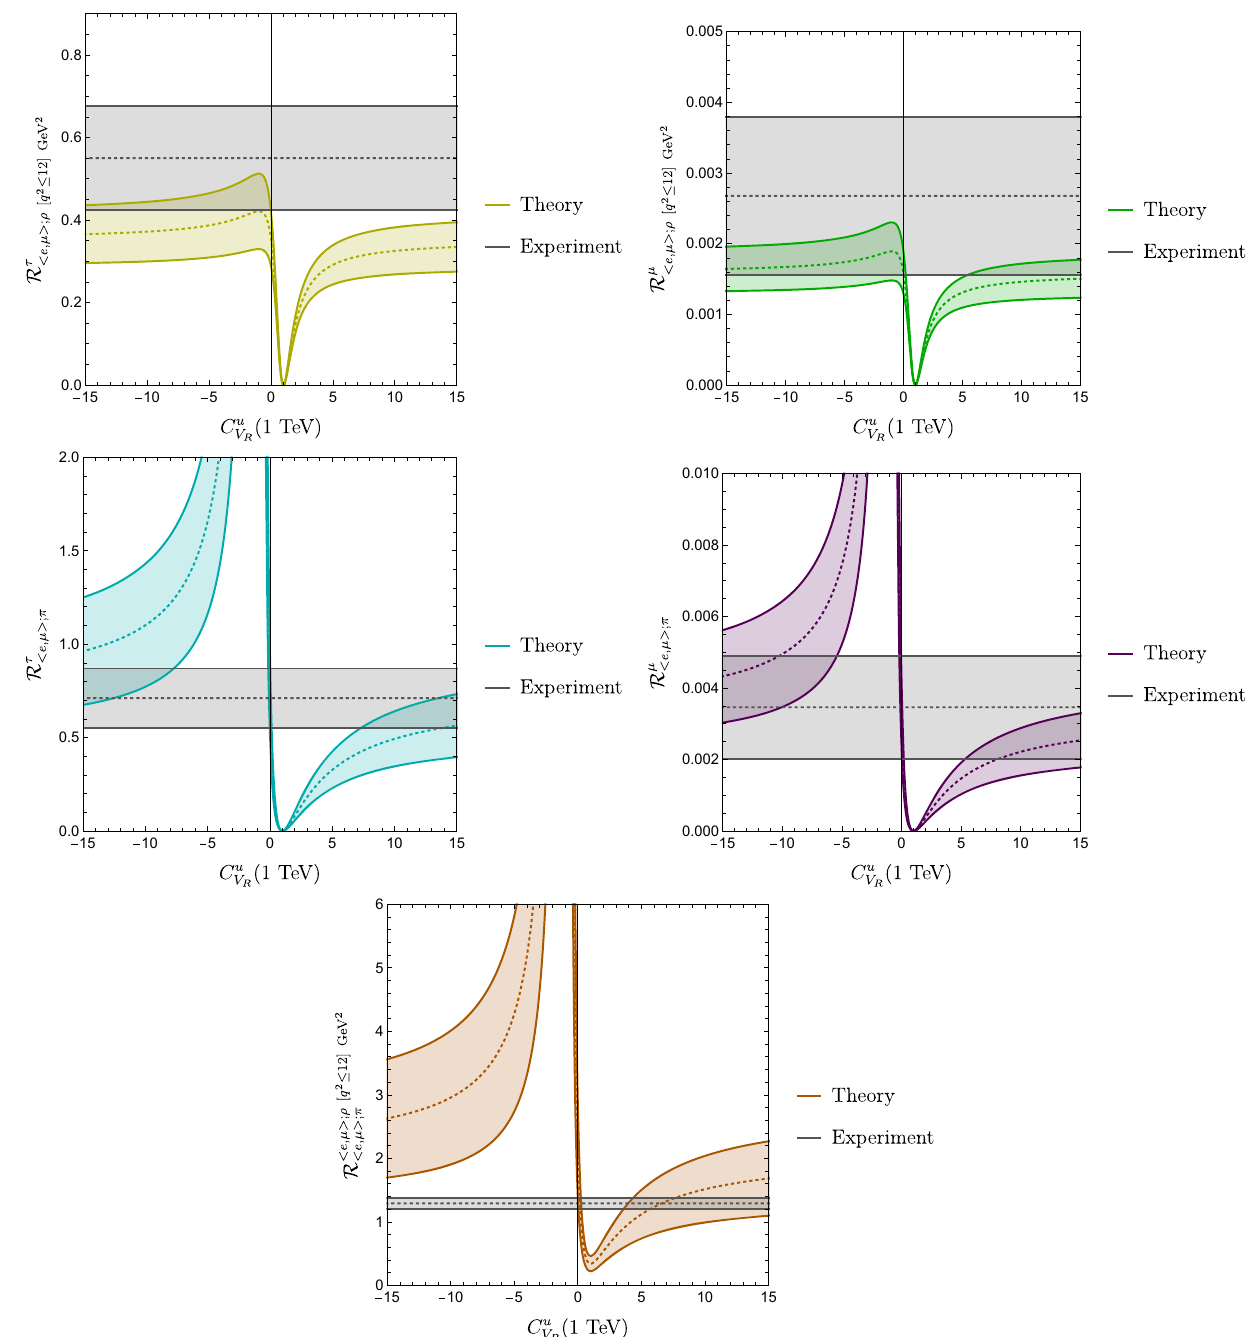
Fig. 6 Dependence of the five observables listed in the text on C u